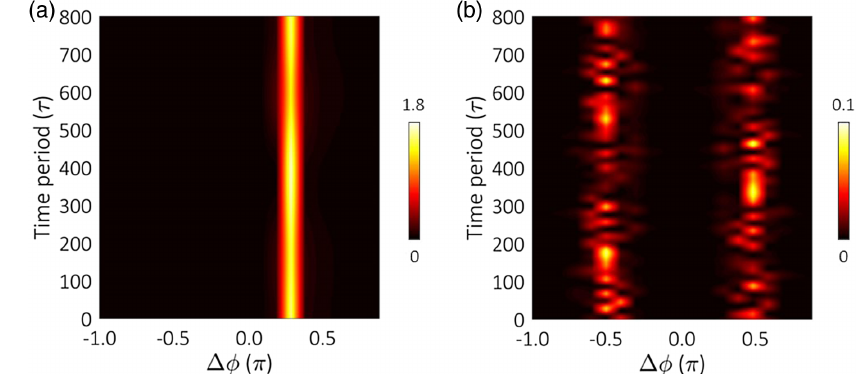
FIG. 3. Temporal dynamics of the phase difference between adjacent resonant modes in the side rings. The color bar indicates the absolute value squared of the spatial Fourier transform of the field inside the side-ring. (a) The topological laser exhibits a fixed phase difference between the modes in the right-hand side ring, which gives rise to the mode locking. (b) The trivial laser displays multivalued phase differences between the modes of the same ring, which therefore cannot be synchronized to yield mode-locked operation. The time axis is in units of τ ¼ 2 π = Ω